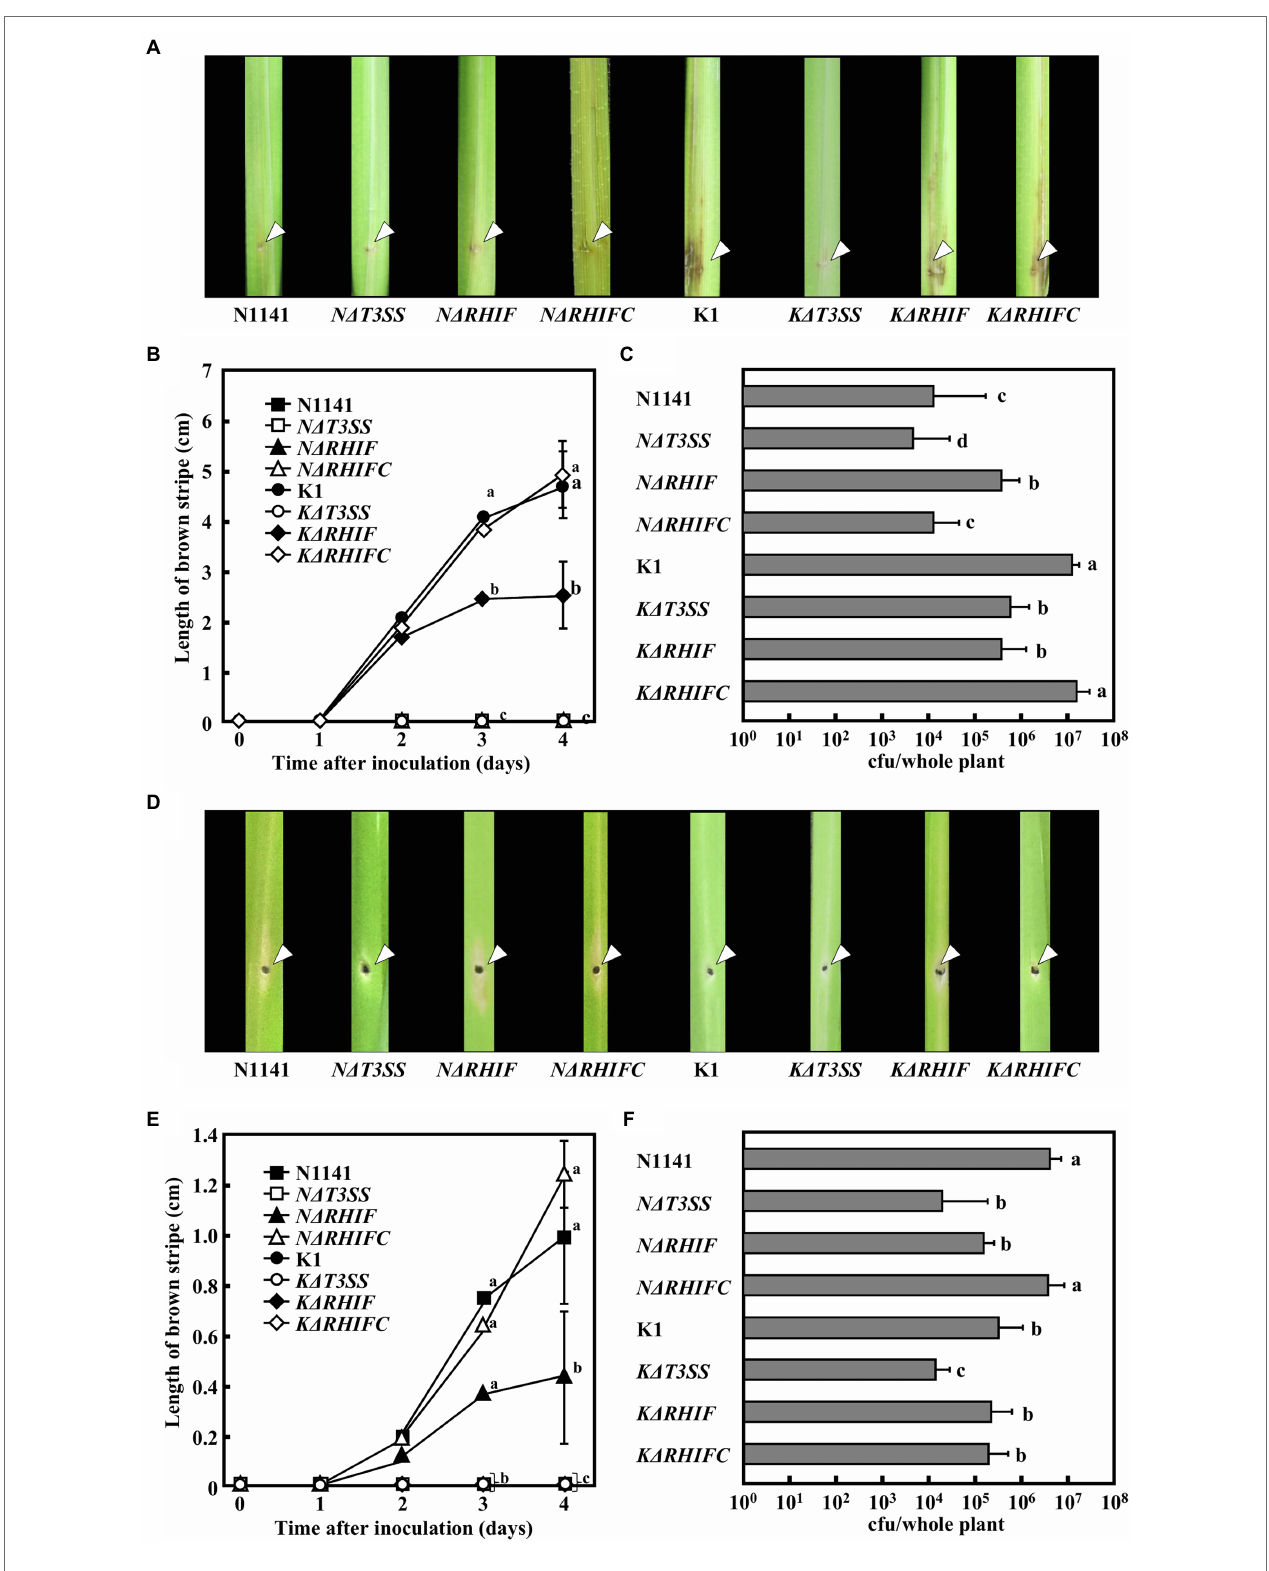
FIGURE 7 | Inoculation tests of N1141, N Δ T3SS , N Δ RHIF , N Δ RHIFC , K1, K Δ T3SS , K Δ RHIF , and K Δ RHIFC . (A) Photographs of rice inoculated with each strain. Each strain was inoculated into rice using the single-needle method, and symptoms were observed 4 days later. The arrow indicates the inoculation